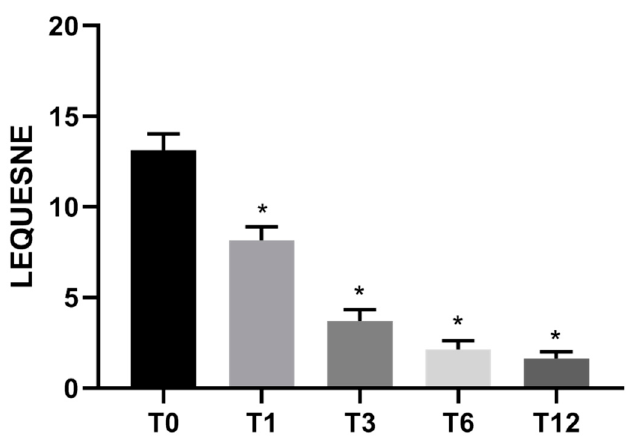
Figure 3. Mean Lequesne functional score ( n = 30) before and after Lipocell treatment. T0 is pre- treatment, Tx is x months after the treatment. Error bars show SEM * p vs. pre-treatment <0.01.